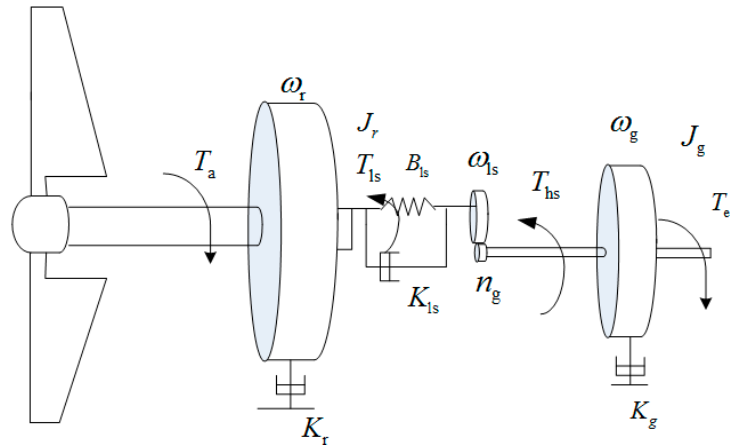
Figure 3. Simplified two-mass model of wind turbines.